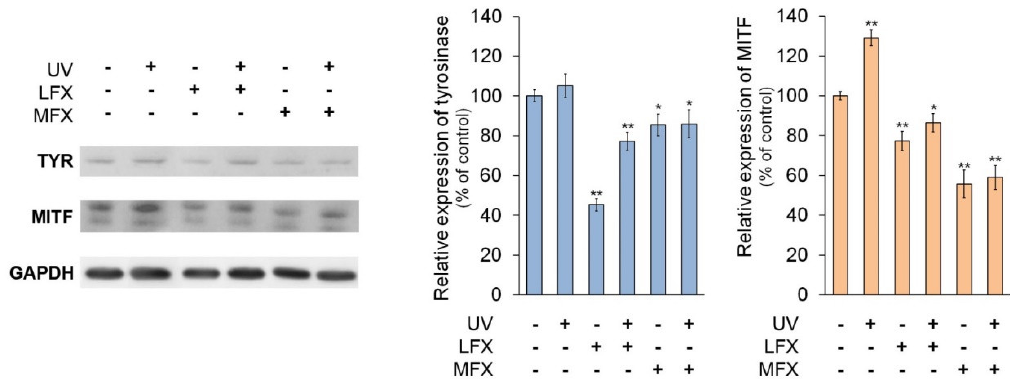
Figure 6. Fluoroquinolones alone and plus UVA radiation modify the expression of tyrosinase and microphthalmia-associated transcription factor (MITF) at the protein level in melanocytes. The cells were exposed to lomefloxacin (LFX) in concentration of 0.05 mM and moxifloxacin (MFX) in concentration of 0.1 mM. The protein levels of tyrosinase and MITF were determined by Western-blotting 24 h after the irradiation. Bar graph represents mean ± SD from three independent experiments. * p < 0.05, ** p < 0.01 vs control.